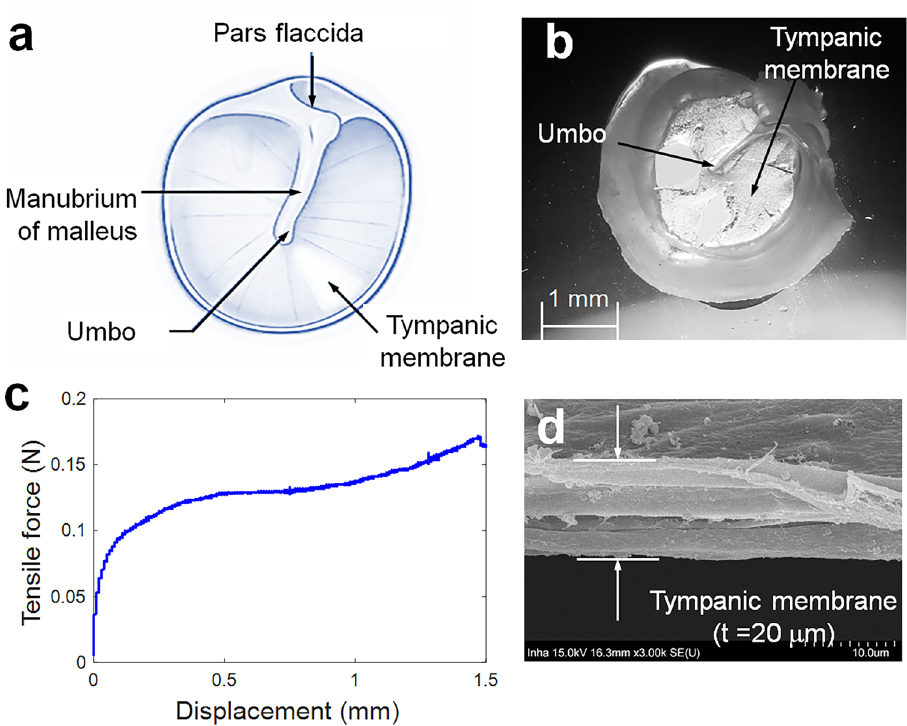
Figure 1. Tympanic membrane (eardrum) as an acoustic diaphragm: ( a ) peripheral view (human), ( b ) microphotography (young rat, provided by Inha University Hospital), ( c ) measured force (stress) vs displacement (strain) curve of a TM extracted from a young guinea pig using a micro tensile tester (Daeyeong), ( d ) cross-sectional microscopic scanning electron microscopy images (young rat, ×